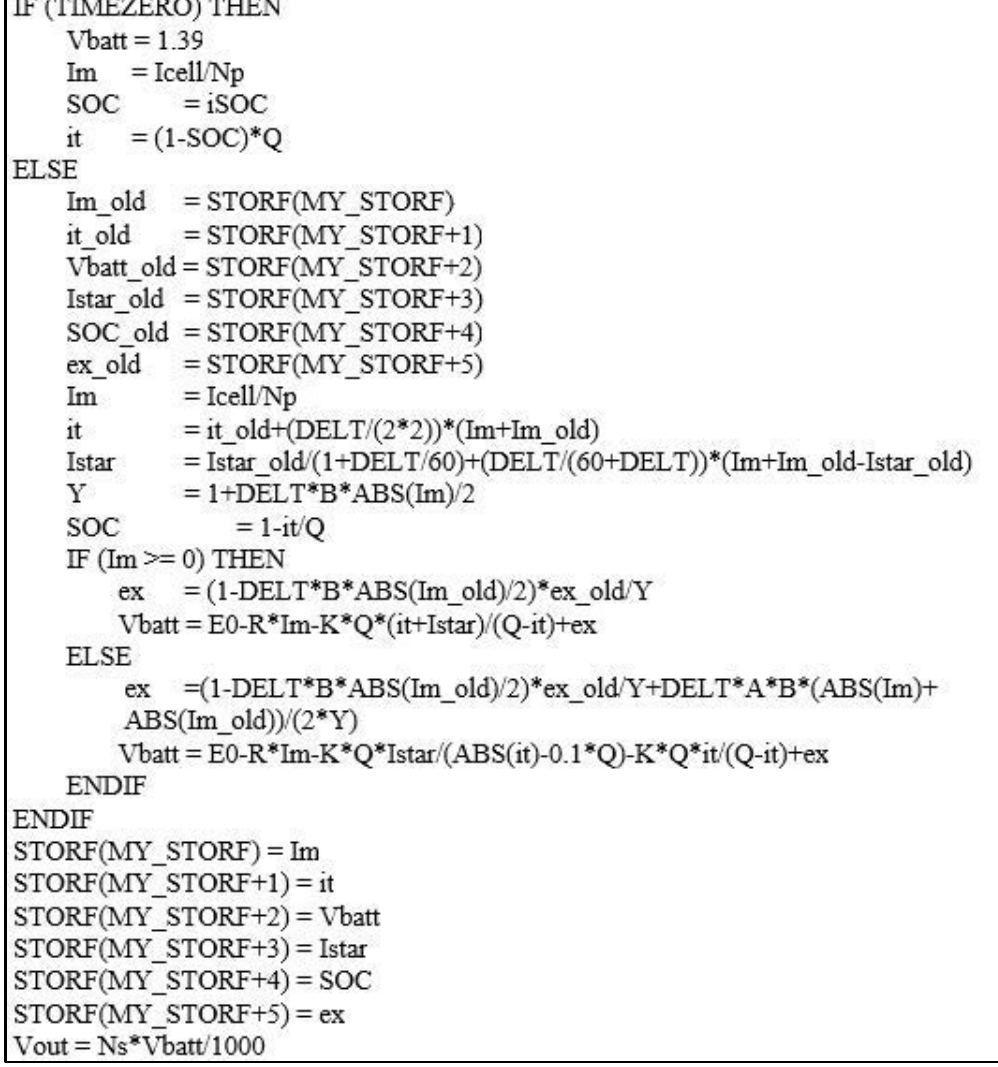
Figure 17. Fortran code for battery model characteristics.